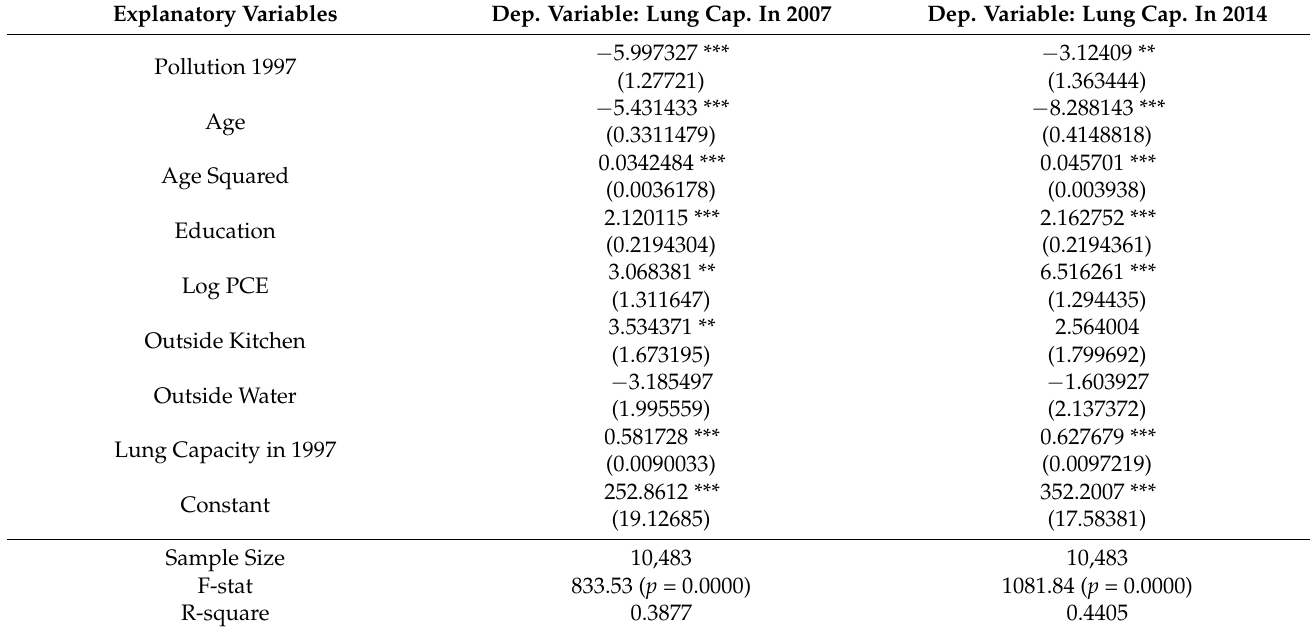
Table 1. Lung Capacity Regression